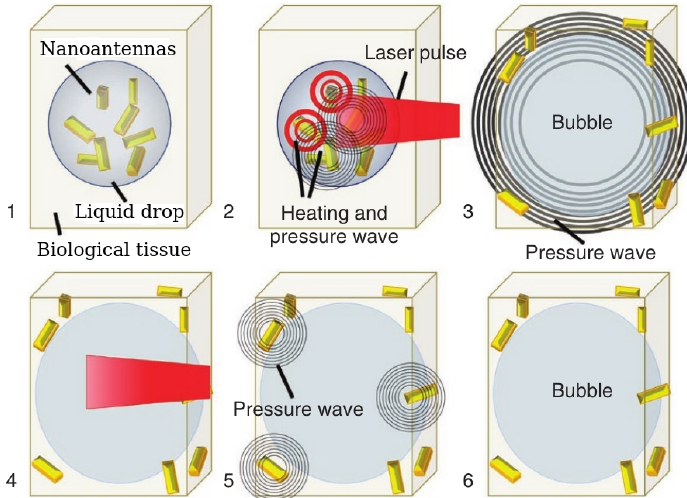
Figure 15. Diagram of a step-by-step remote activation of photoacoustic contrast agents via two phys- ical mechanisms: vaporisation of liquid nanodroplets (steps 2 and 3) and thermal expansion caused by plasmonic nanoantennas (steps 4 and 5). The formed microbubble (step 6) provides contrast for ultrasound imaging. Reproduced from [194] with permission of Springer Nature. Copyright 2012.